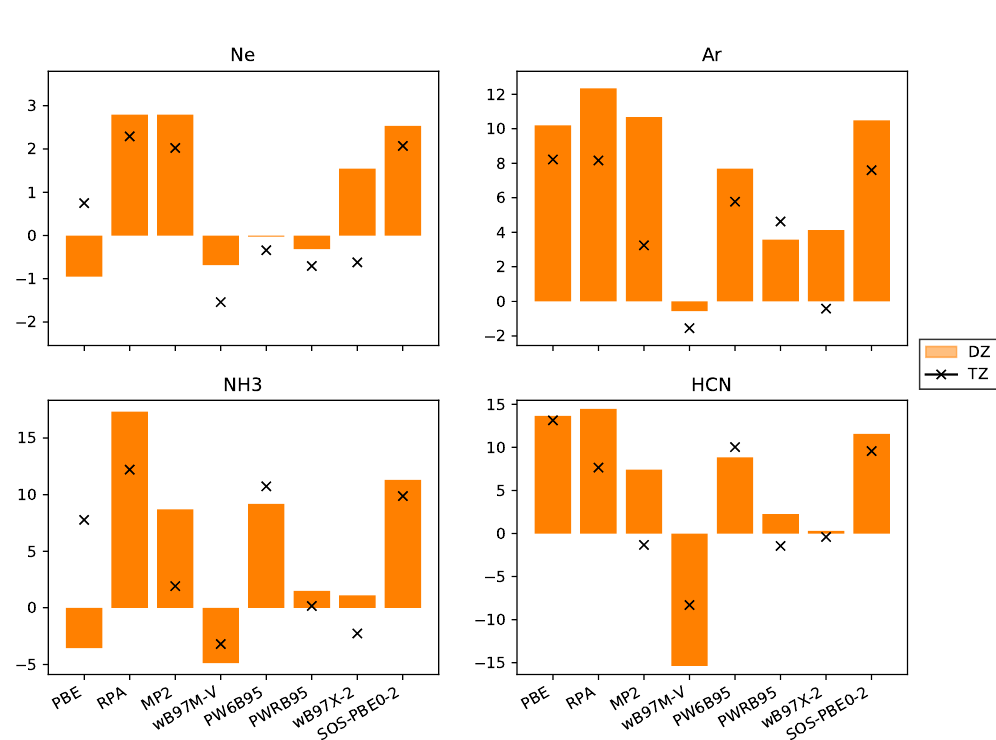
Figure 3. Errors in cohesive energies in kJ · mol − 1 with respect to the experimental values with basis sets of DZ and TZ quality for the systems Ne, Ar, NH 3 ,